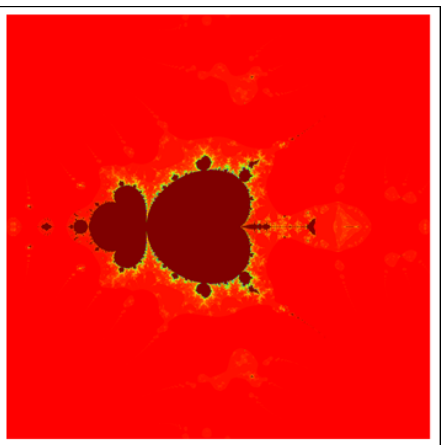
Figure 44. M-set via F-iteration for sin ( z 2 ) + c with image visual time = 149.2 s.